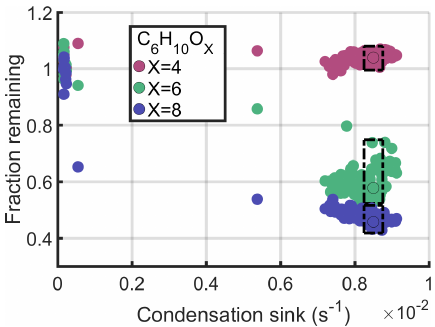
Figure 5. Condensation behaviour of three C 6 H 10 O x species. Sig- nals are normalised so that the median of the signal before the ABS seed experiment is set to 1. Thus, shown on the y axis is the re- maining fraction of the signal of each molecule at a given conden- sation sink. The dashed-line boxes encircle data points between the condensation sink values 0 . 825 × 10 − 2 and 0 . 875 × 10 − 2 s − 1 , and circles with a black outline show the median of these boxed-in data